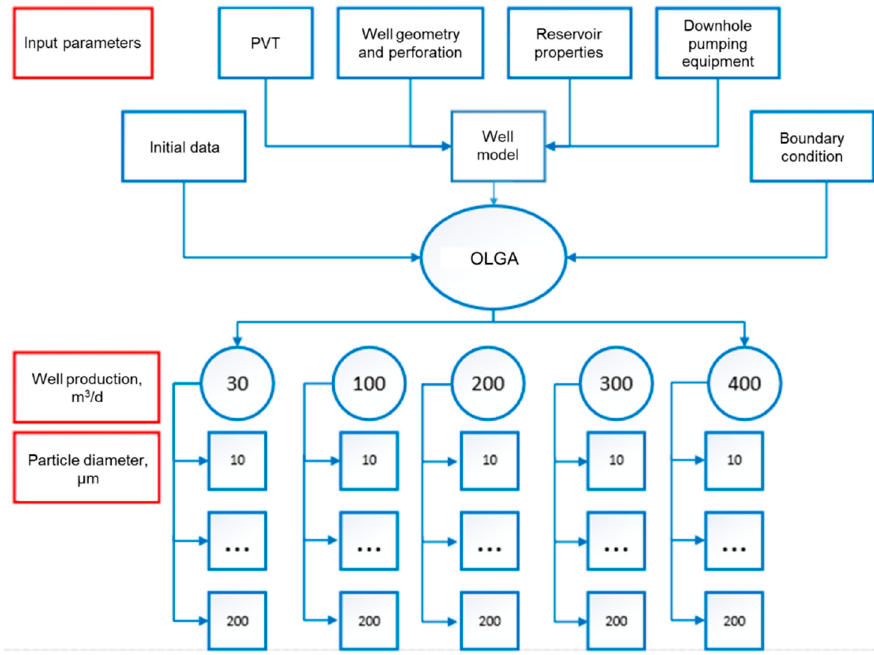
Figure 1. Research algorithm.